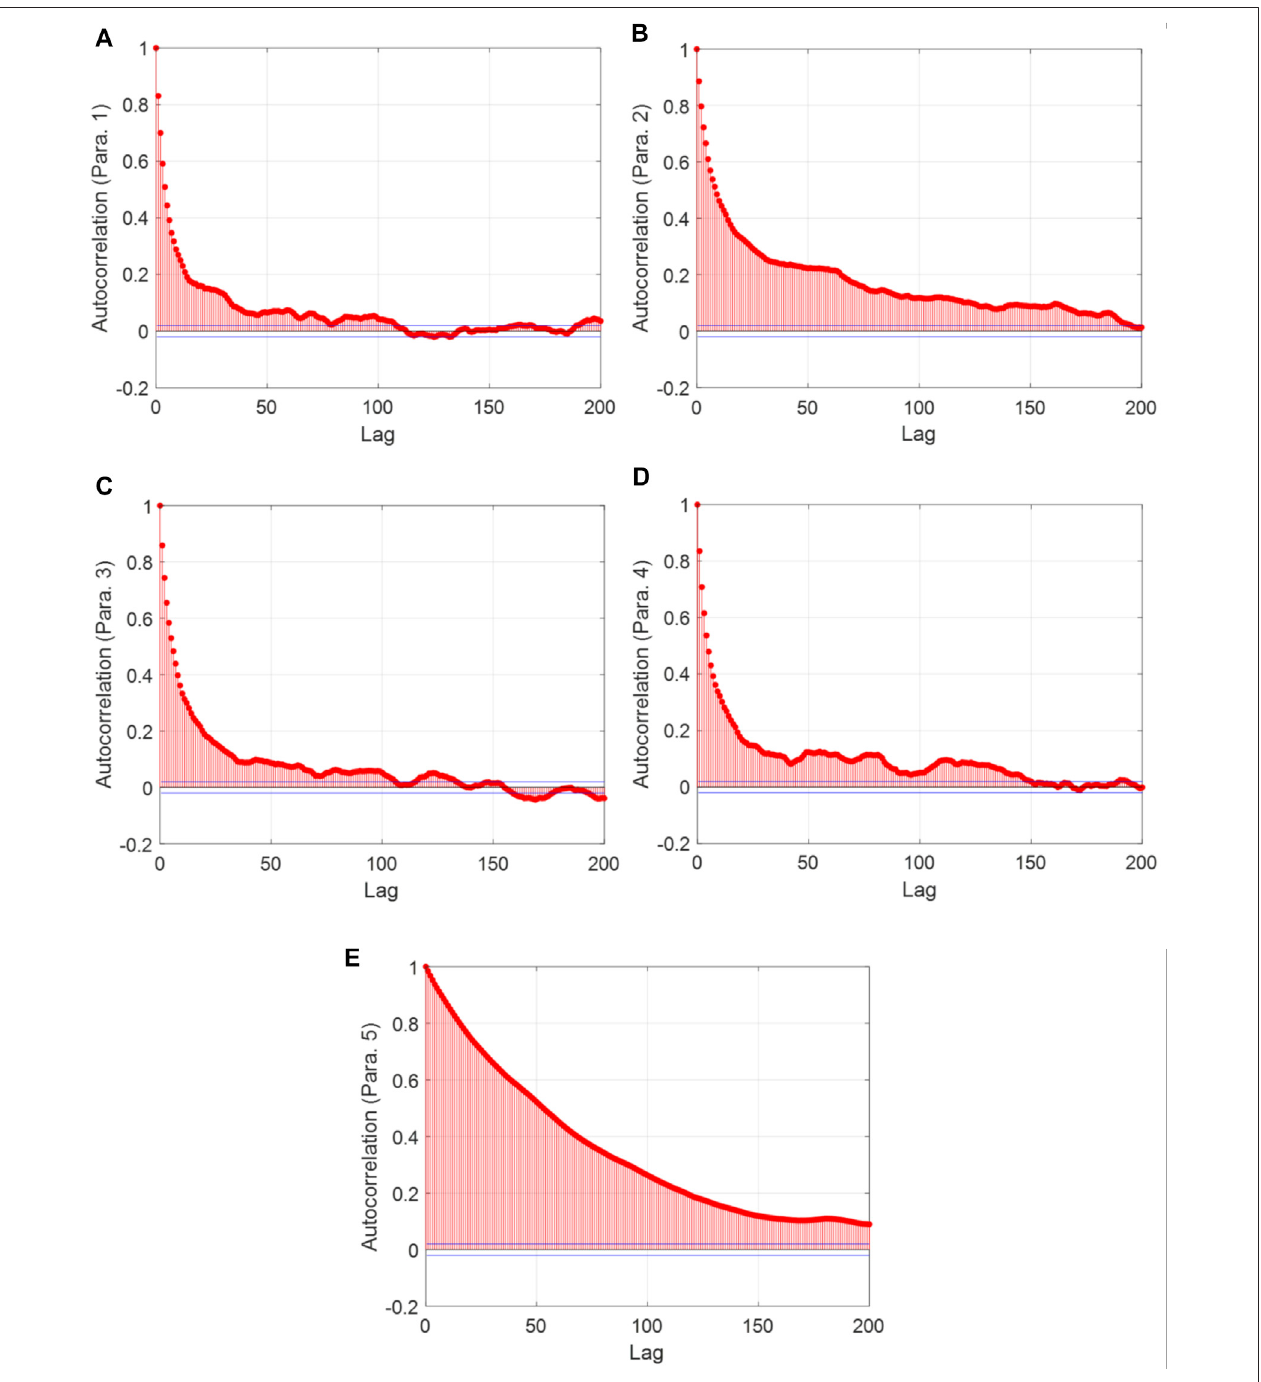
FIGURE 14 | Autocorrelation of MCMC with respect to lag. (A) Parameter 1; (B) Parameter 2; (C) Parameter 3; (D) Parameter 4; and (E) Parameter 5 (case 2).